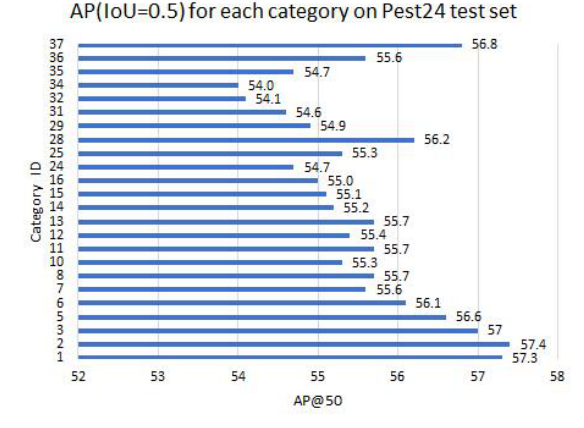
Figure 7. AP (IoU = 0.5) for each category on Pest24 test set.